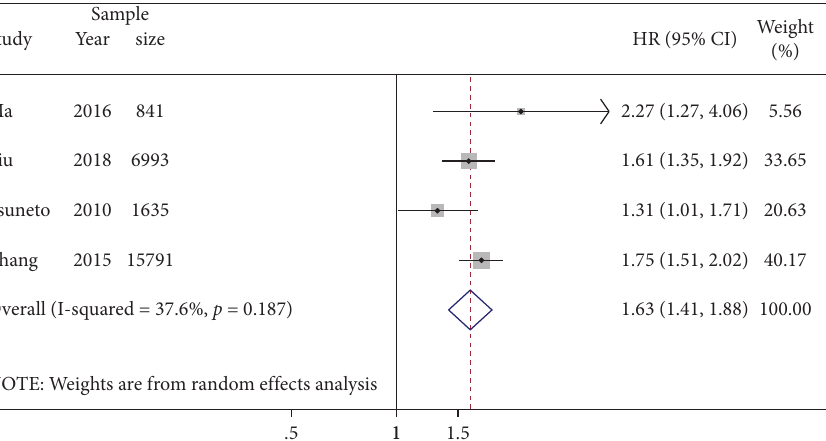
Figure 2: HTN versus non-HTN on the risk of incident NAFLD. Forest plot and pooled estimates of 4 eligible studies with data on 25,260 participants.